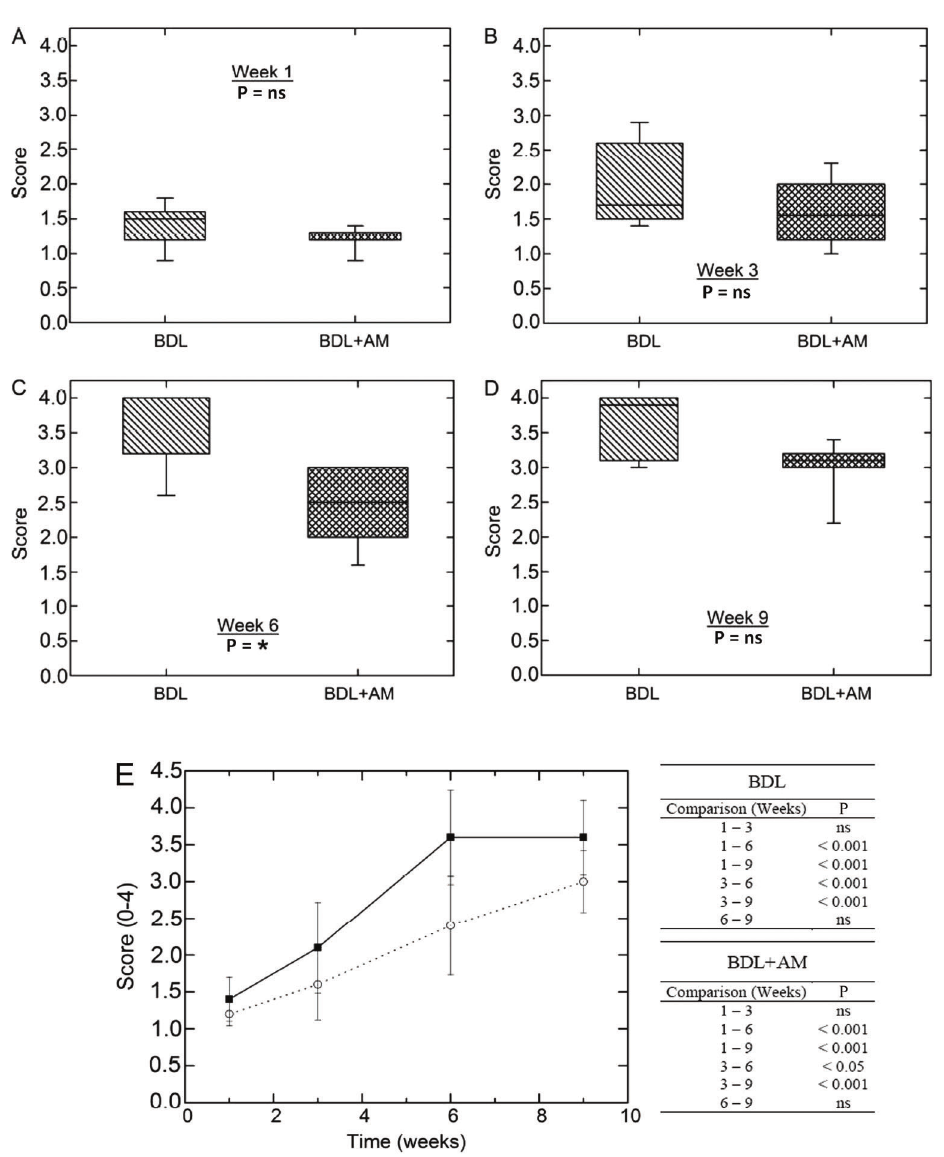
Figure 4. Qualitative evaluation of fi brosis degree by Knodell scoring. Data are reported as median and interquartile range of the fi brosis score in the experimental groups, BDL and BDL + AM at week 1 ( A ), week 3 ( B ), week 6 ( C ), and week 9 ( D ), after fi brosis induction. *P o 0.05, unpaired Student ’ s t -test. ns: not signi fi cant. E , Means ± SD of fi brosis score progression in BDL (squares) or BDL + AM (circles), at different time points. The tables represent the signi fi cance between time points in BDL and BDL + AM groups (one way ANOVA followed by Tukey ’ s multiple comparison test. BDL: bile duct ligation; AM: amniotic